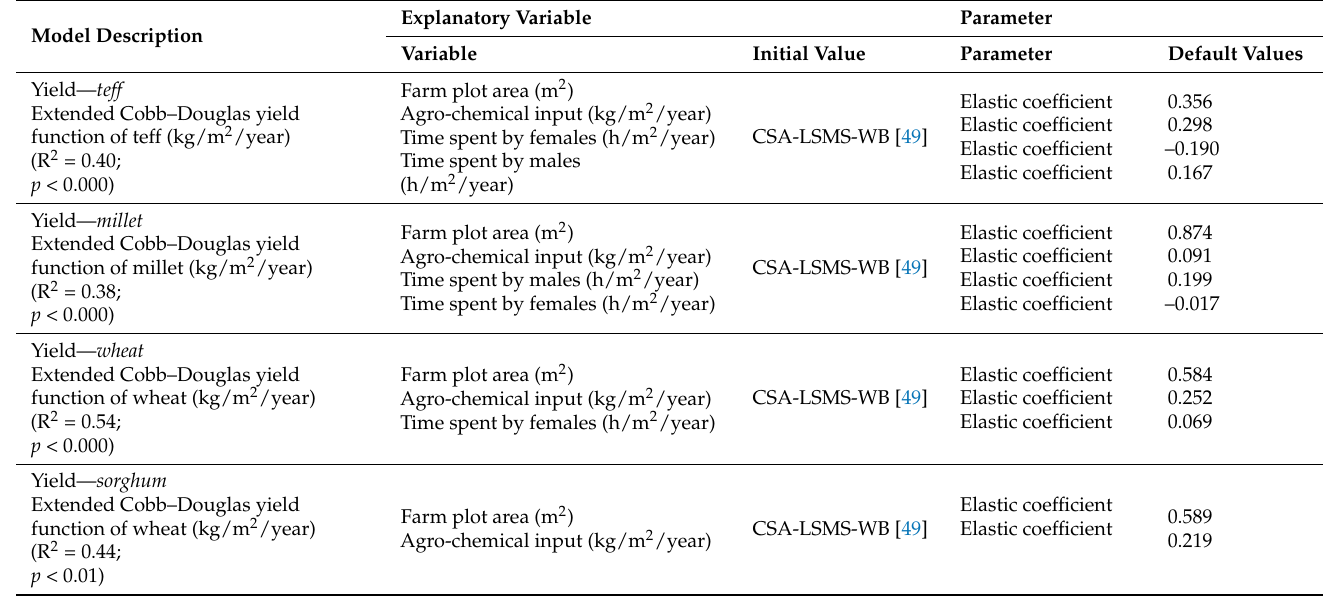
Table 3. Agricultural yield sub-models and parameters of the Gen-ABM.